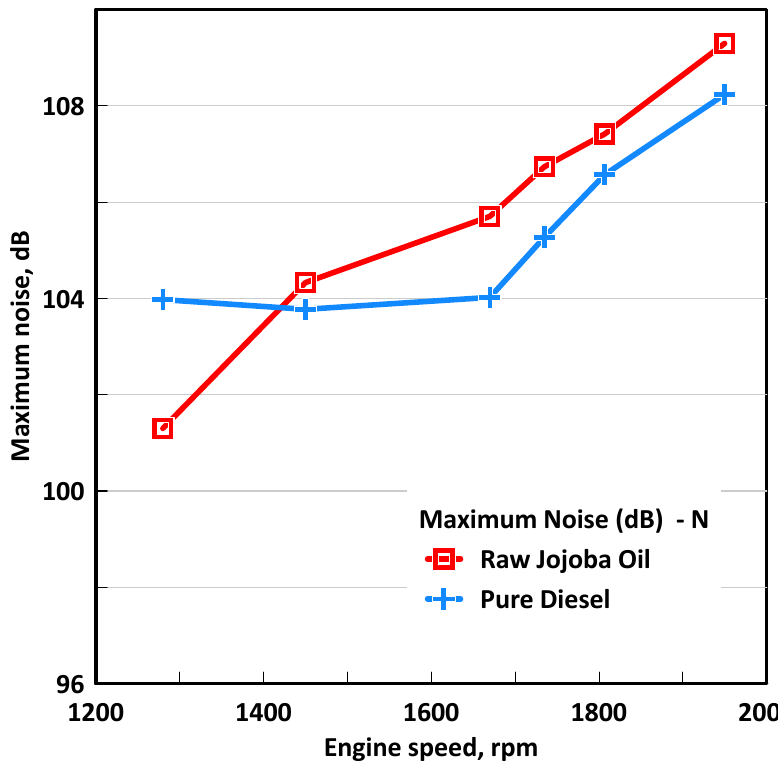
Figure 14. Maximum noise amplitude for ensemble-averaged cycle measured by microphone sen- sor.